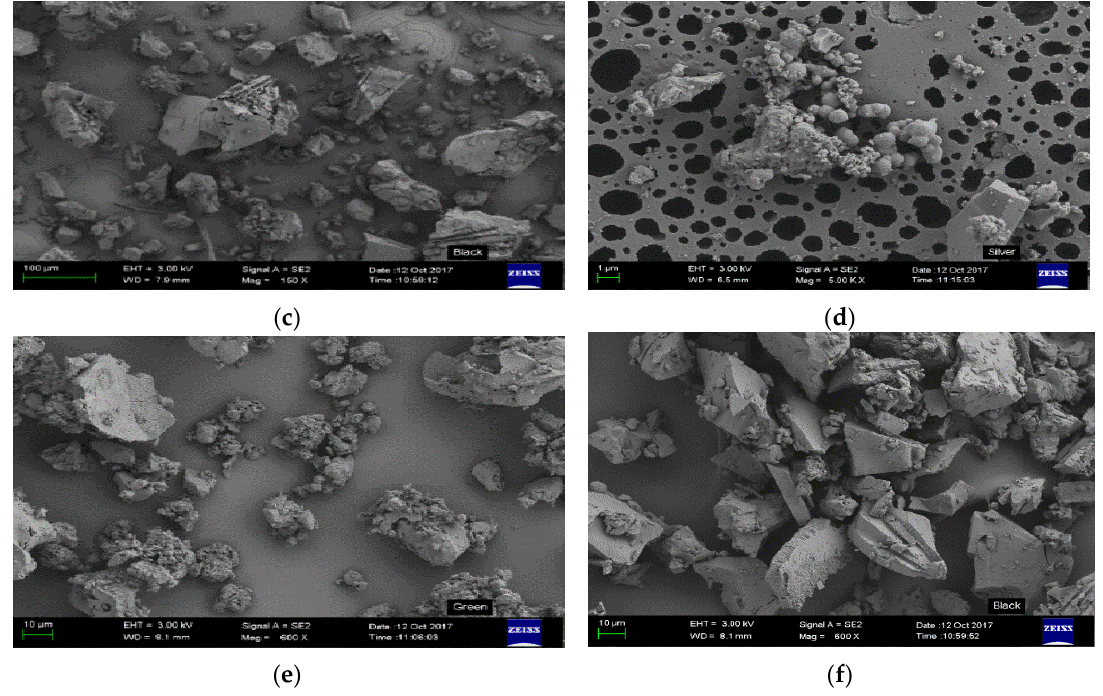
Figure 4. ( a – f ) Micrographs taken in SE mode at a magnification of 50 × for ( a ) STR ( b ) GTR and ( c ) BTR samples. Magnification of 600 × for ( d ) STR ( e ) GTR and ( f ) BTR samples.